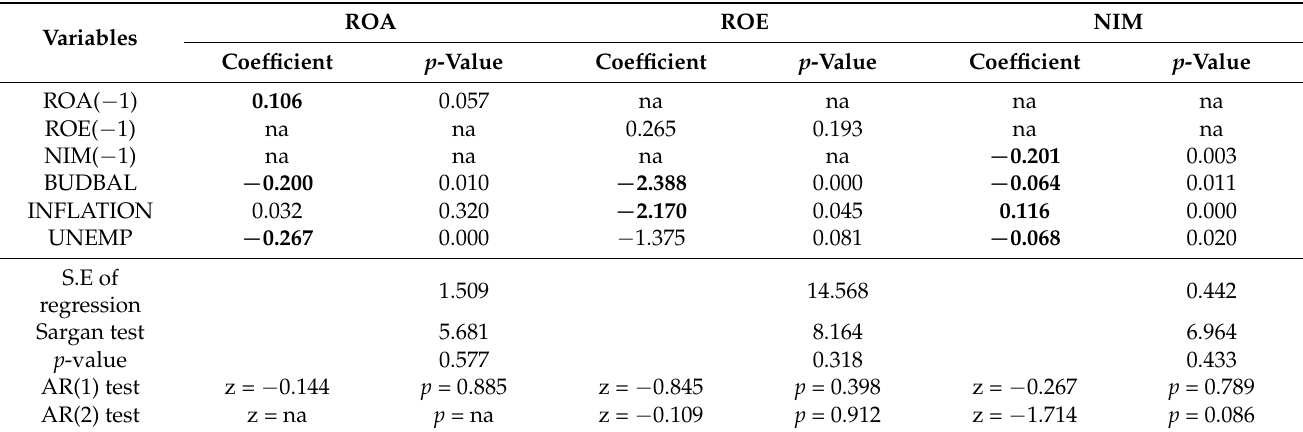
Table 5. Results of System GMM estimations for macroeconomic variables